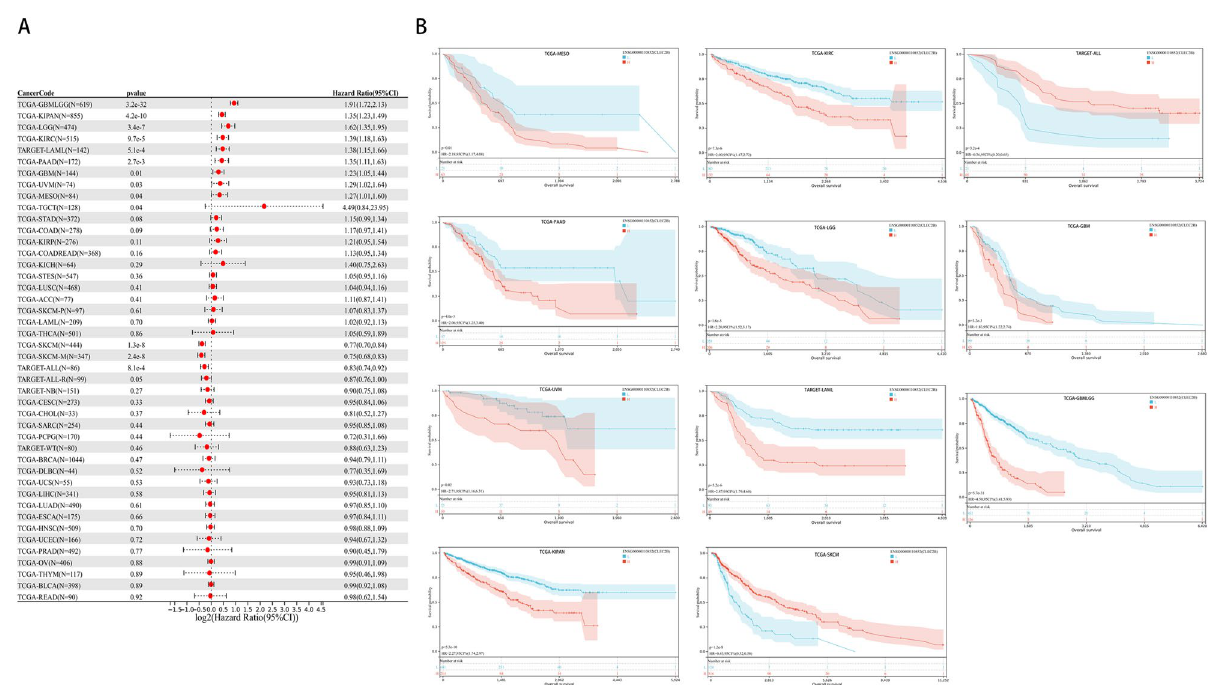
Figure 8. Association between the CLEC2B expression and OS in cancer patients. ( A ) A forest plot of hazard ratios of CLEC2B in 32 types of tumors. ( B ) Kaplan–Meier survival curves of OS for patients stratified by the different expressions of